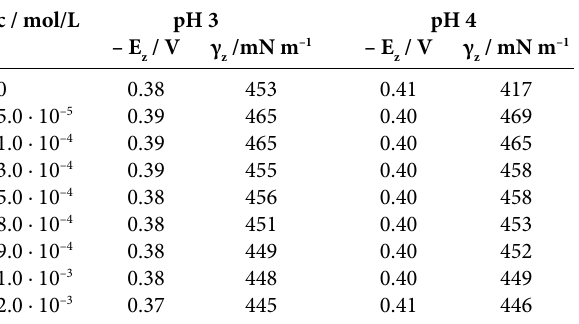
...of Table 1. The values of the zero charge potentials E vs Ag/AgCl elec- z trode and surface tension γ at E for the studied systems. z z Figure 4. Correlation between the surface charge density on mercury and the potential of the electrode for an acetate buffer at pH 3 (A) and pH 4 (B) in the function of adenine Gugała-Fekner: The Effect of Adenine Adsorption on Zn (II)